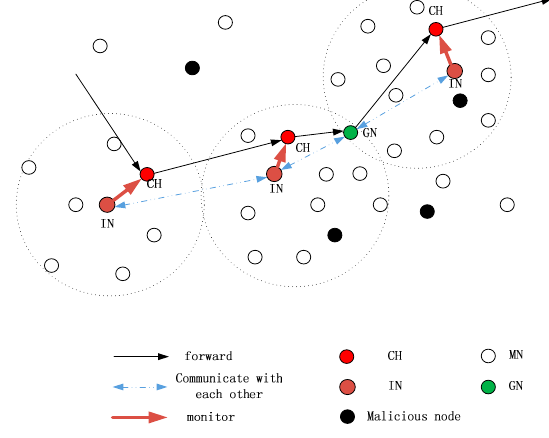
Figure 2. Local Figure 2. Local monitoring.